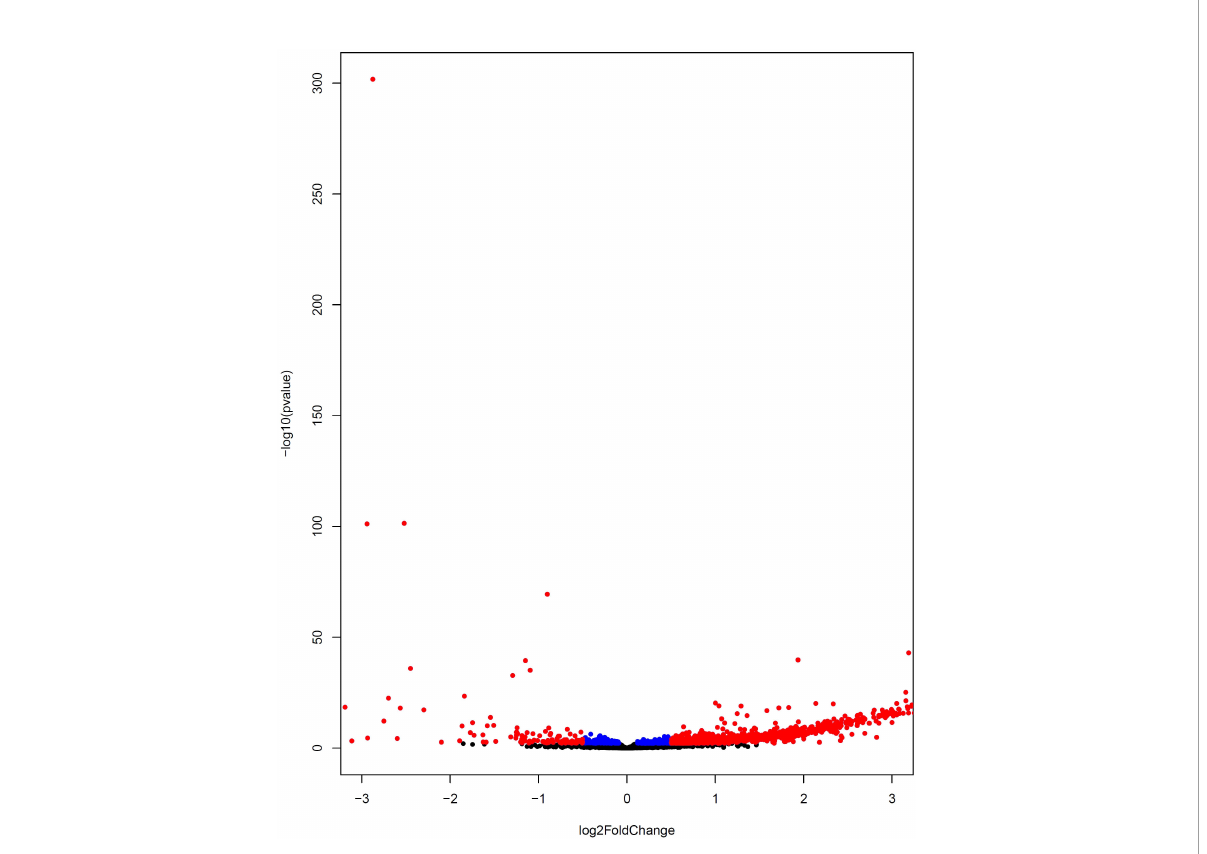
FIGURE 6 Volcano plot indicating differential gene expression between severe COVID-19 and non-severe COVID-19 subjects. The upregulated and downregulated DEGs are displayed by colors of red and blue, respectively. The non-DEGs are depicted by the black color.